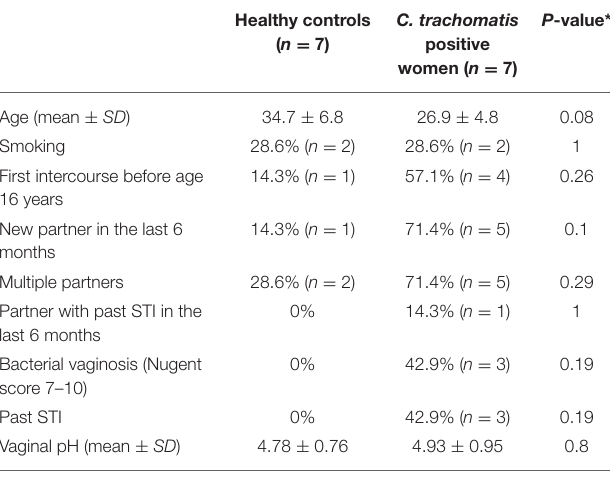
TABLE 1 | Characteristics of the study population.